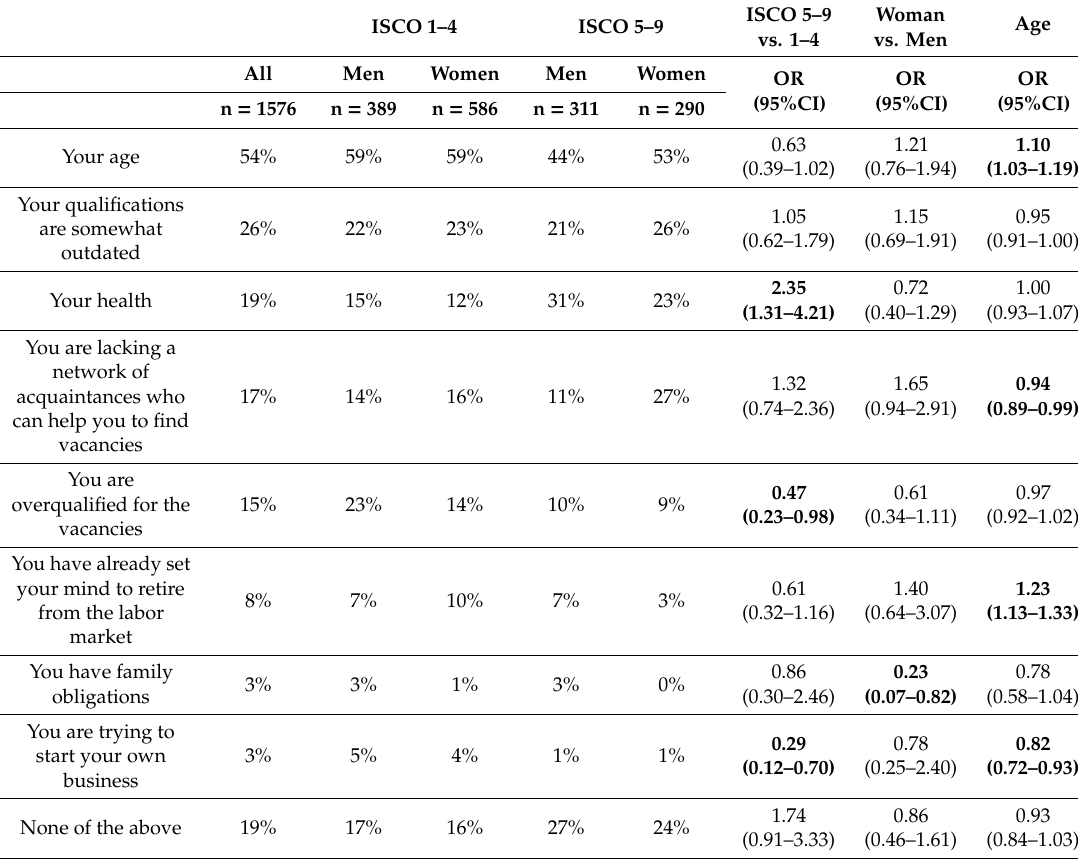
Table 2. Barriers to re-employment among men and women in ISCO groups 1–4 and 5–9. The first five columns are percentages of the respondents indicating this barrier, and the last three columns are OR’s and 95% CI. Significant associations are marked with